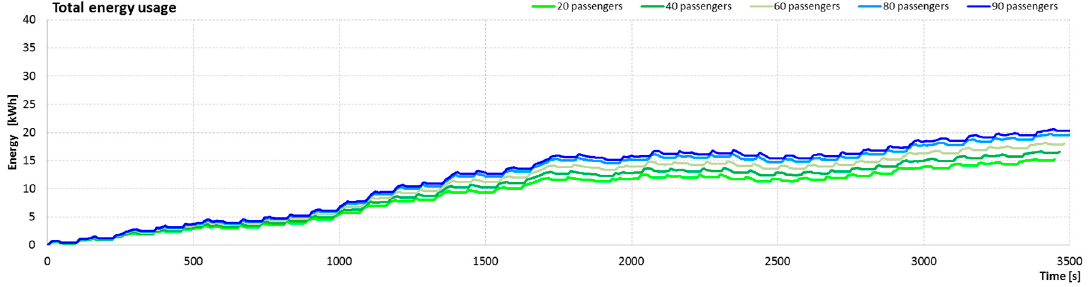
Figure 26. Results of simulation tests for the Gdynia-Flat route during changes of the number of passengers.